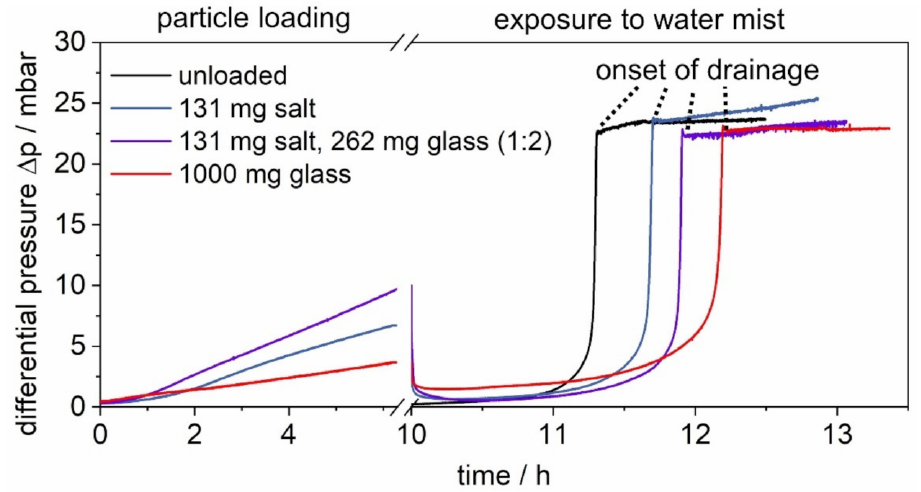
Figure 13. Differential pressure plots during the exposure with water mist of an unloaded filter, a salt-laden filter, a filter loaded with a mixture of salt and glass particles, and a glass-laden